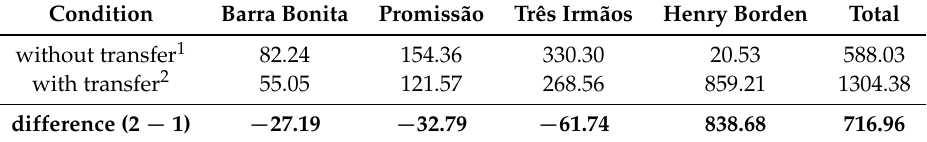
Figure 9. Comparison of hydraulic generation with and without water transfer for case study 01. Table 1. Comparison of hydroelectric generation average with and without transference (average